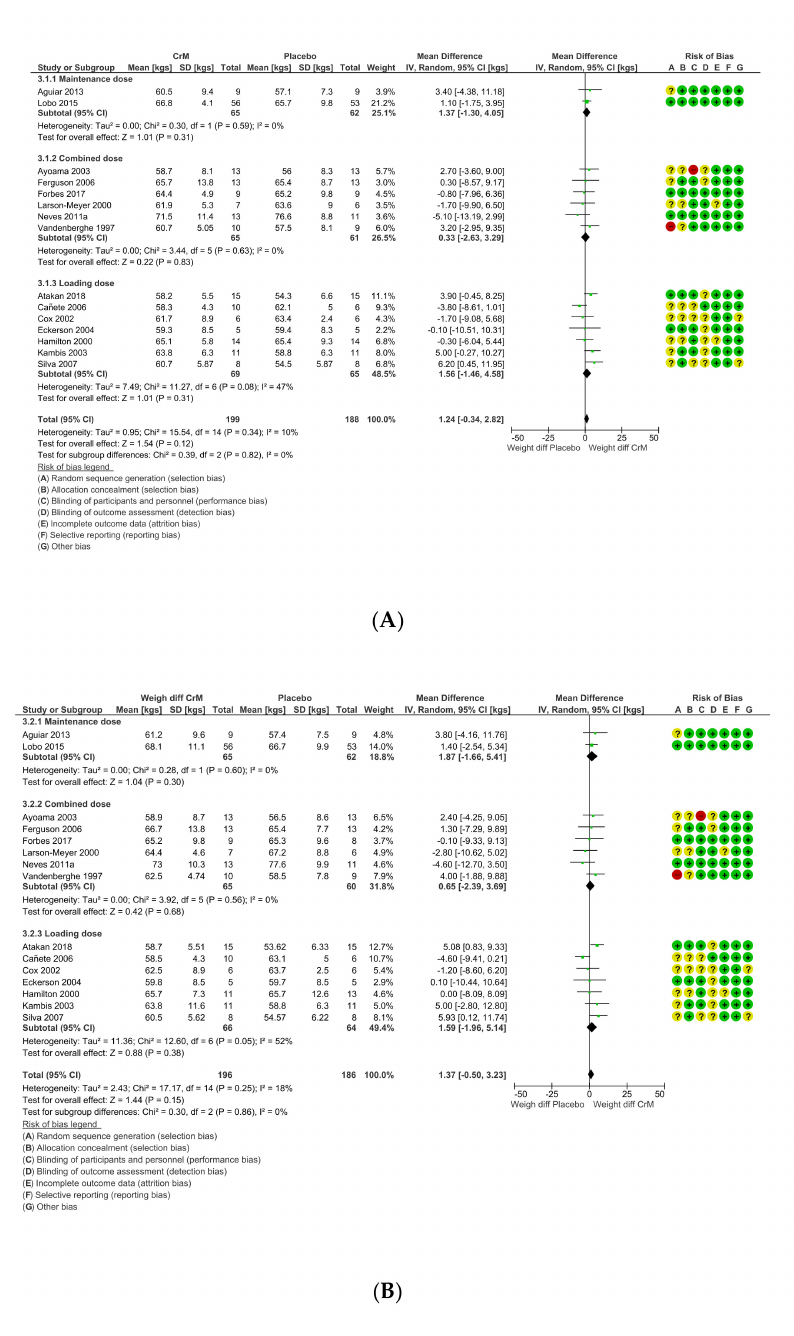
Figure 8. ( A ) Di ff erence in body weights per group, pre-intervention, stratified by dosing regimens. Within Forest Plot, Study or Subgroup = study stratified by dosing regimens; Mean = mean body weight per group in kgs; SD = standard deviation; Total = total number of participants in study group; Weight = amount of information contributed by study; I-V = Inverse Variance random e ff ects model. ( B ) Di ff erence in body weights per group, post-intervention, stratified by dosing regimens. Within Forest Plot, Study or Subgroup = study stratified by dosing regimens; Mean = mean body weight per group in kgs; SD = standard deviation; Total = total number of participants in study group; Weight = amount of information contributed by study; IV = Inverse variance model; Random = random e ff ects model; Risk of bias; + (green) = low risk of bias, ? (yellow) = unclear risk of bias, - (red) = high risk of